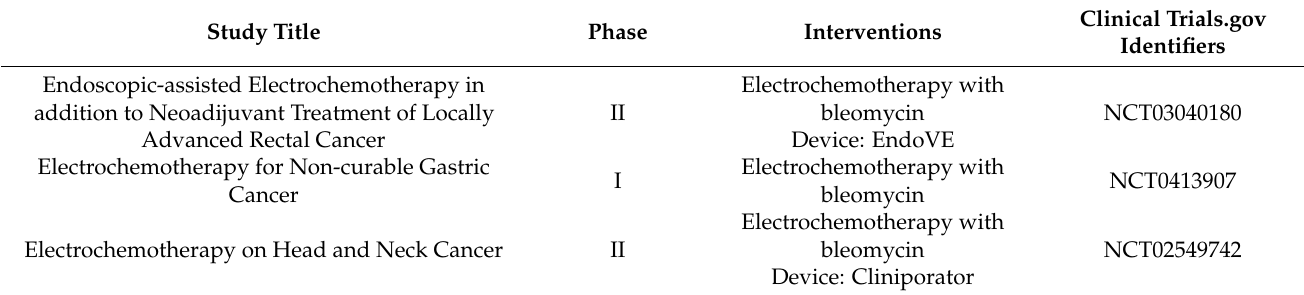
Table 1. Overview of clinical trials of